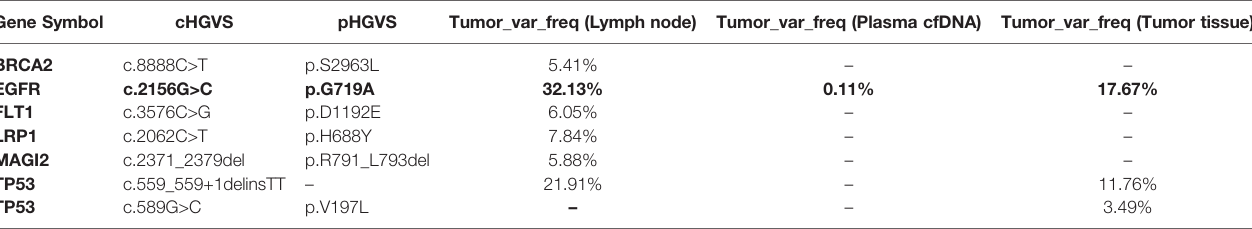
FIGURE 1 | CT scan of the patient before and after induction therapy showed the tumor response. CT, Computed tomography. TABLE 1 | NGS-detected alterations (snv and indel) in the lymph node, plasma cfDNA, and tumor